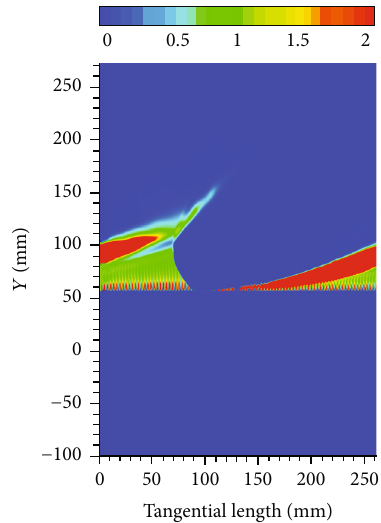
Figure 7: Unwrapped equivalence ratio contour of case 1.